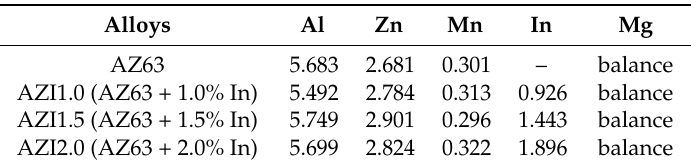
Table 1. Actual chemical composition of the AZ63 and AZI alloys analyzed by inductively coupled plasma mass spectrometry (ICP-MS)